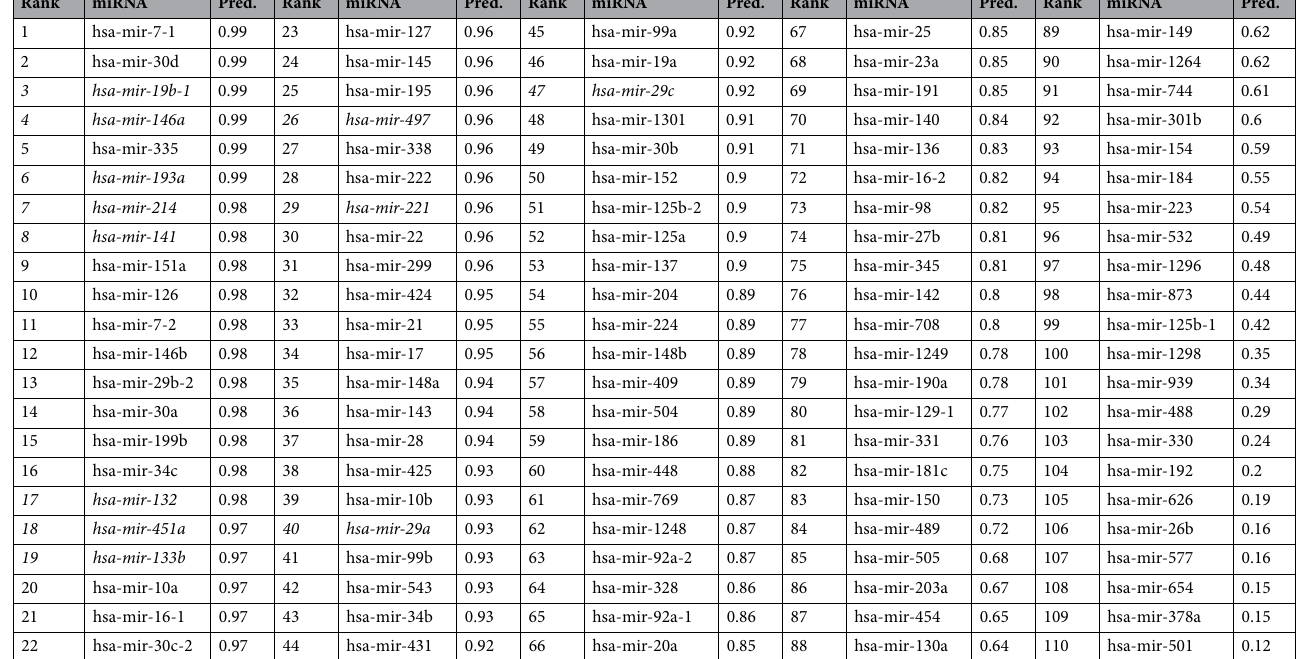
Table 8. The predicted association probabilities for the true positive (marked as italics) and true negative miRNAs 66 corresponding to the Parkinson